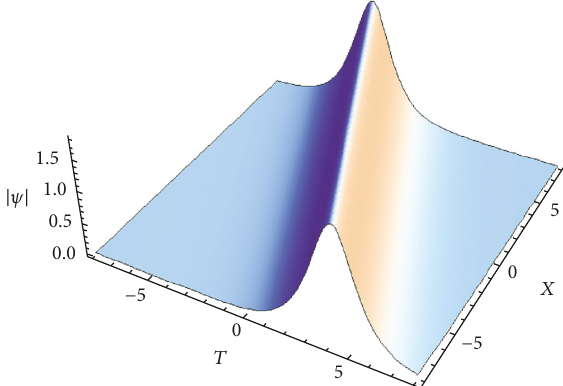
Figure 5: Spatial structure of the module of solution